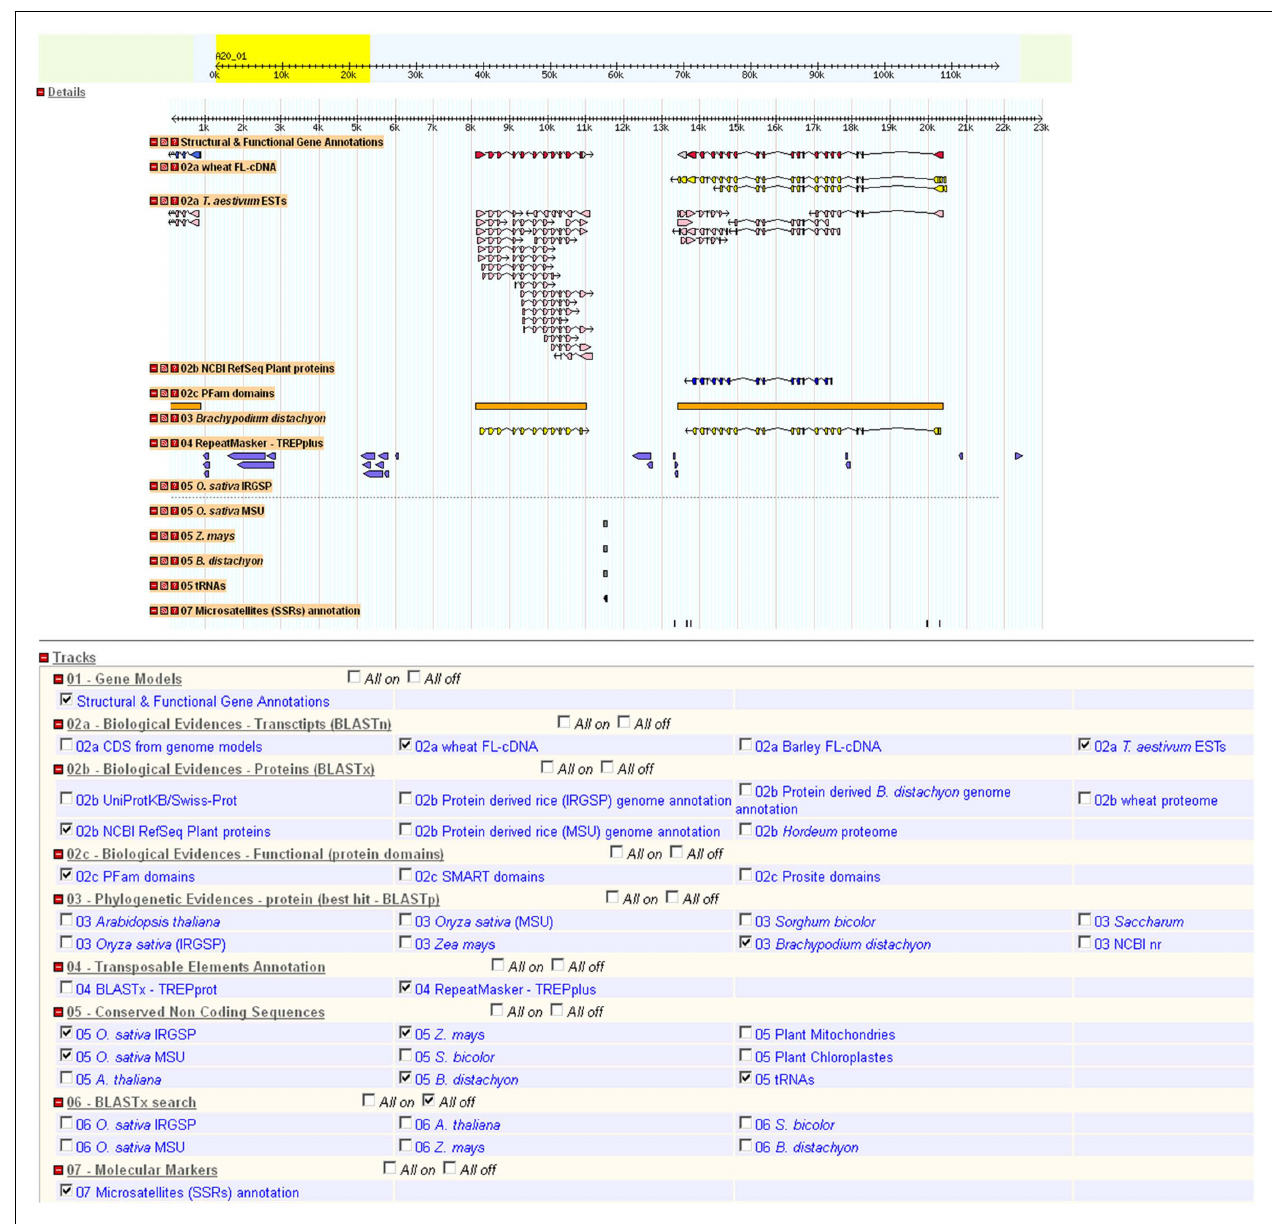
databases that were used for the annotation of this sequence.The “Structural and Functional Gene Annotations” track represents the final gene models with the six color index categories described in Figure 2 . All other tracks are biological or ab initio evidences.The GBrowse display is available only for a default